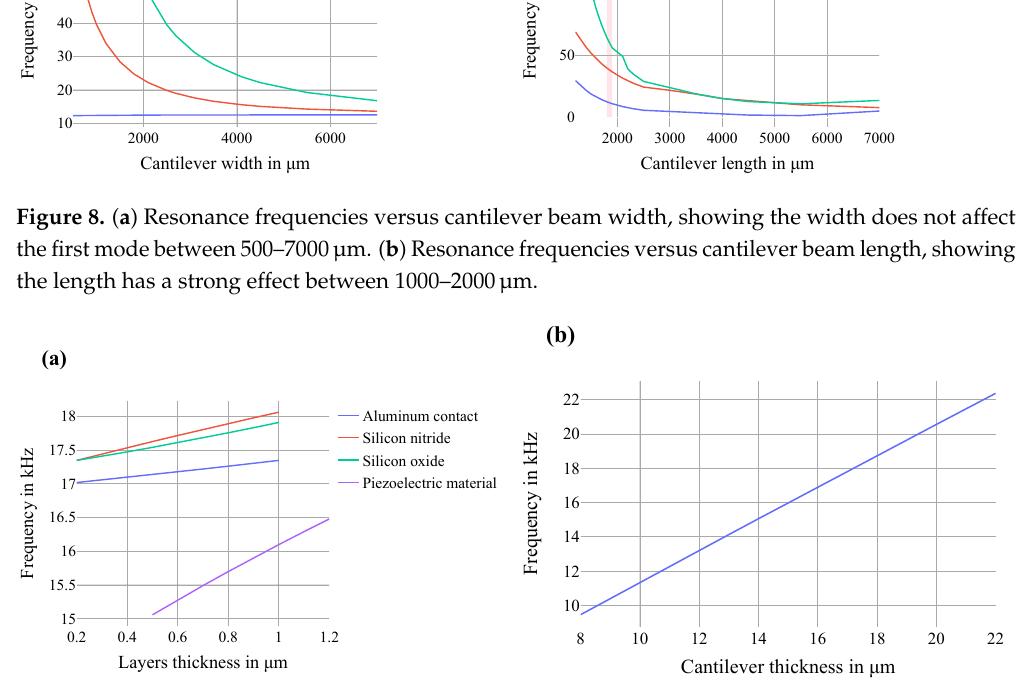
Figure 9. ( a ) Different layers thickness versus the cantilever beam first mode resonance frequency, showing the layers thickness linear effect on the frequency. ( b ) Cantilever beam thickness versus the cantilever beam first mode resonance frequency, showing the beam thickness linear effect on the